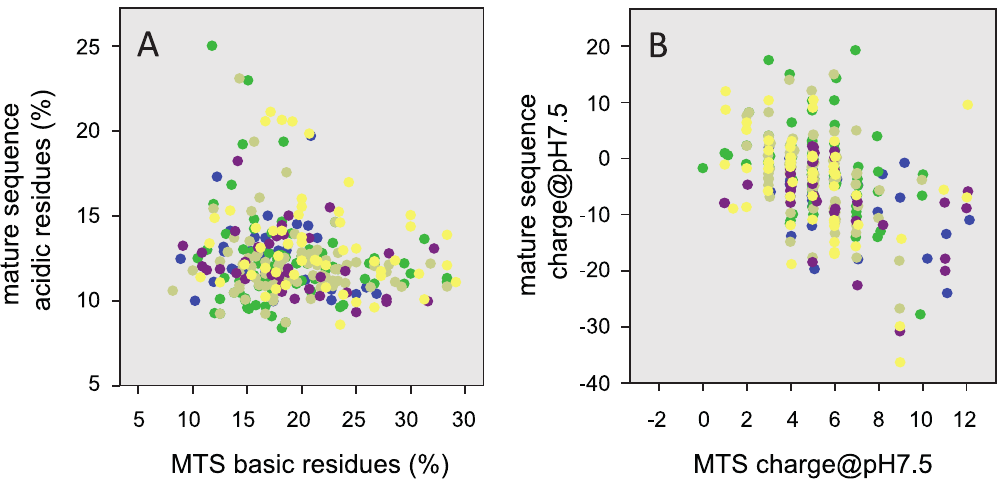
Figure 3. Correlation analysis of charge characteristics between MTS and mature sequences. Scatterplots were generated to investigate (A) basic residue composition (percentage of total) of the MTS against acidic residue composition of the mature sequence, and (B) global sequence charge characteristics by comparing charge at pH 7.5 of both MTS and mature sequences. Blue – H. sapiens , Green – M. musculus , Beige – S. cerevisiae , Purple – A. thaliana , Yellow – O. sativa .